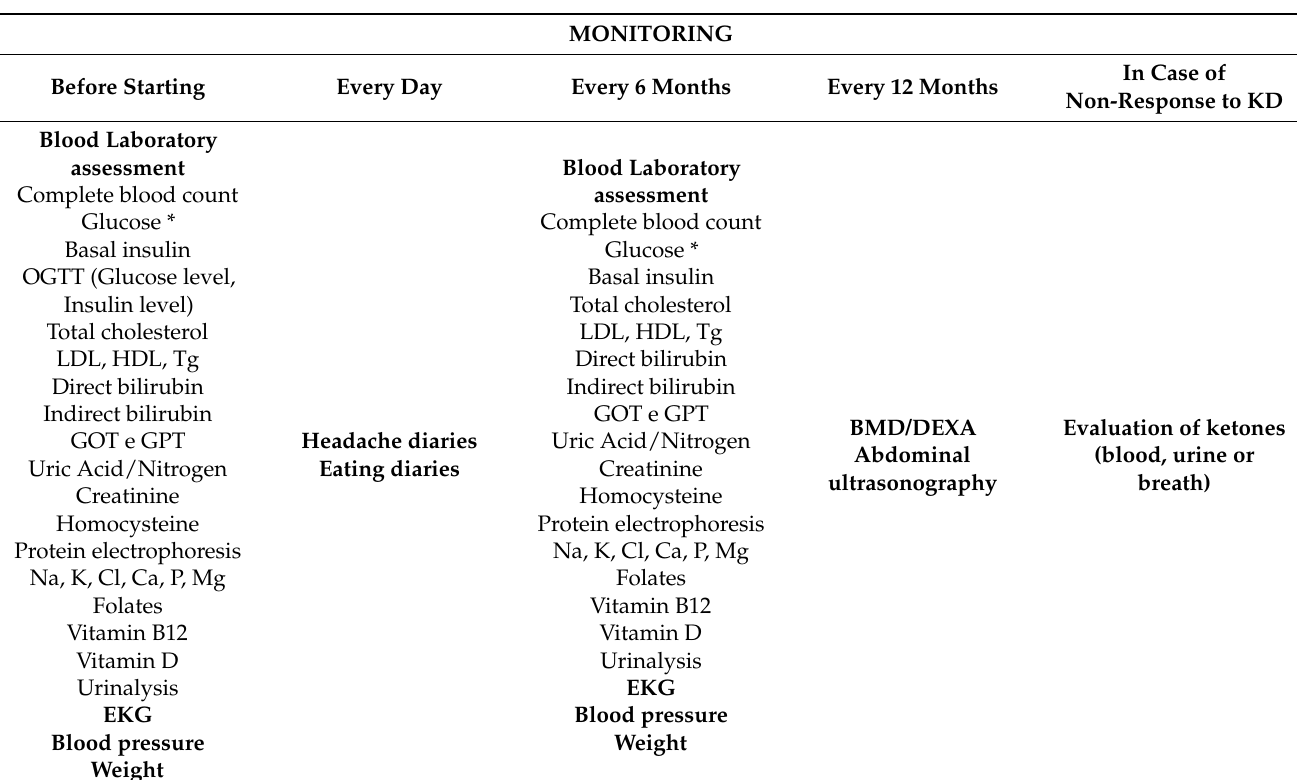
Table 3. Patient